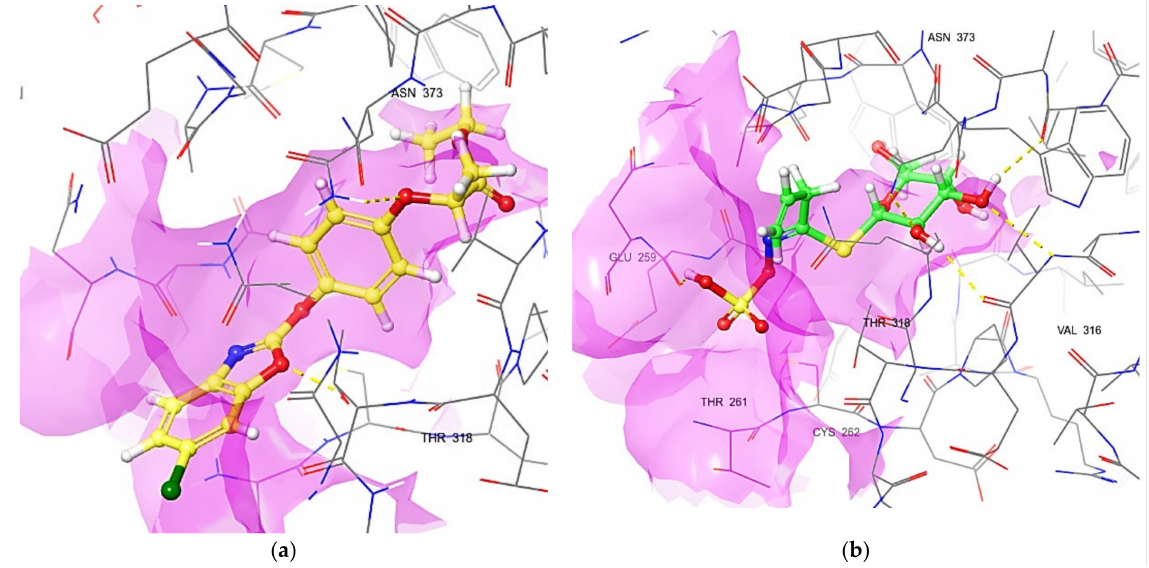
Figure 4. Docked pose of ACCase with ( a ) fenoxaprop-p-ethyl and ( b )